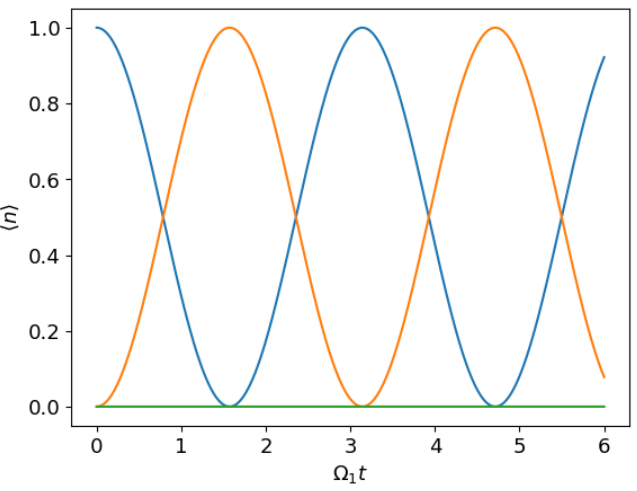
Figure 5. Time evolution of the excited motional state occupation for three coupled particles. The blue line corresponds to the first particle, the orange line to the second particle and the green line to the third particle. We start from a state | 100 (cid:105) , where only the first particle is excited, and set the distances to d 12 = 3/4 λ 1 , d 23 = 7/8 λ 1 , k 2 = 4/3 k 1 and Ω 2 = 0.82 Ω 1 . Choosing these parameters, the interaction between the third and the other two particles can be turned off, while the first two particles still interact with each other. Deactivating the interaction between specific particle pairs is necessary to implement bipartite quantum